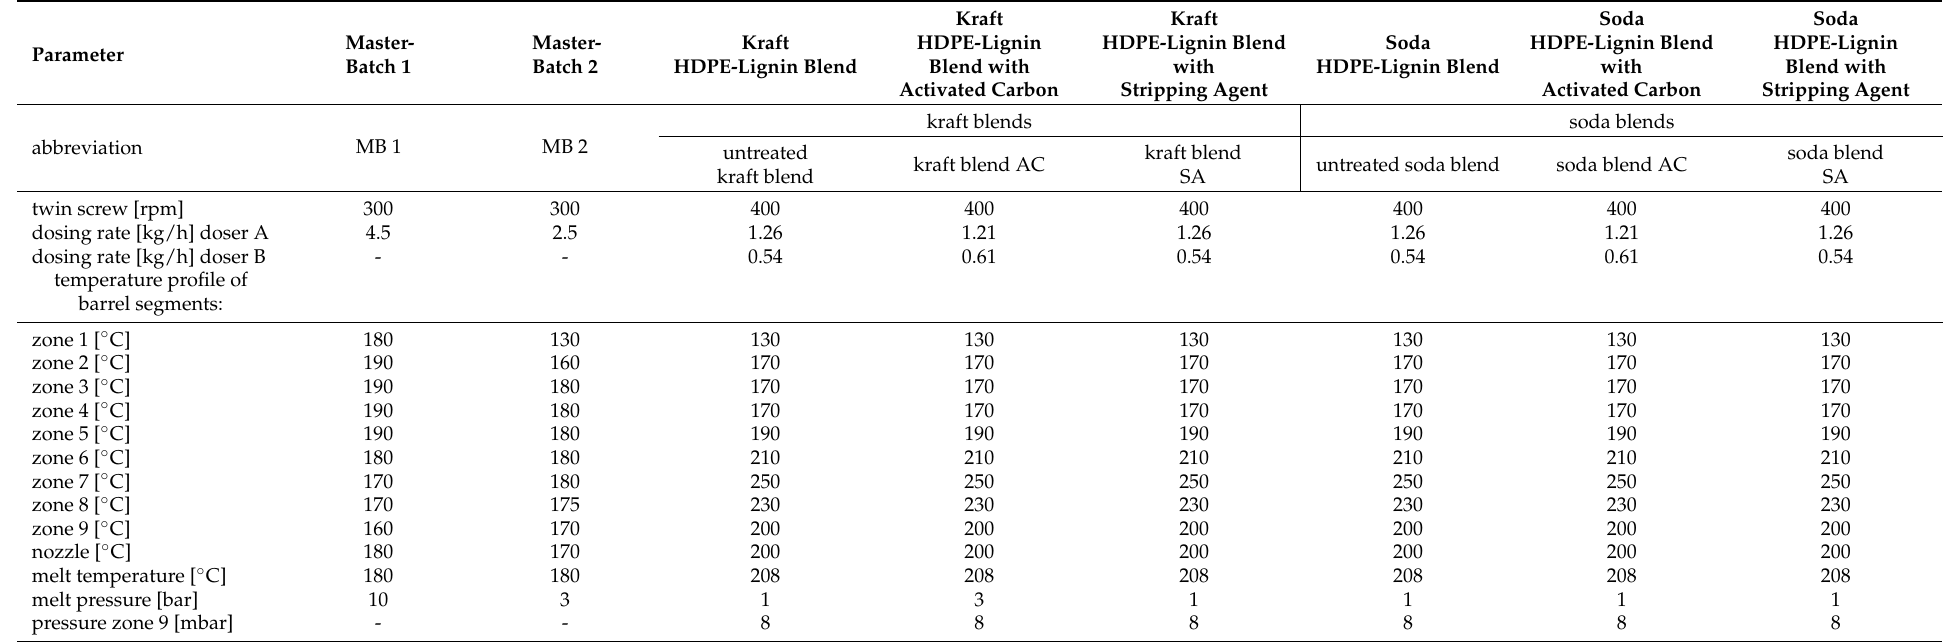
Table 2. Technical parameters of the production of masterbatches and HDPE-lignin